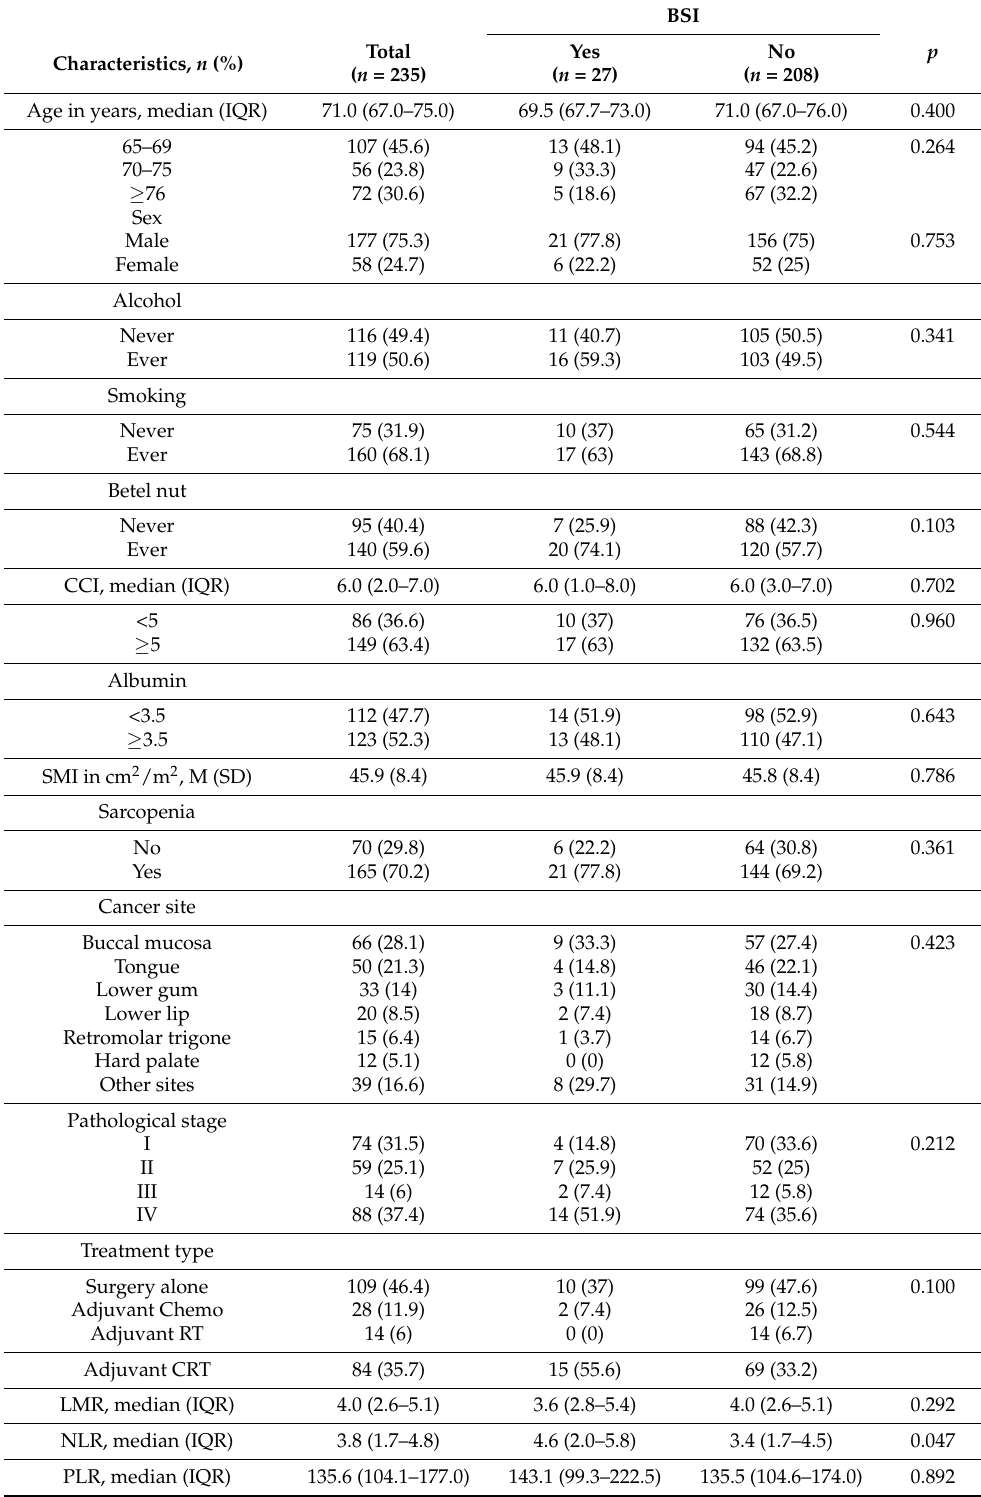
Table 1. Patient